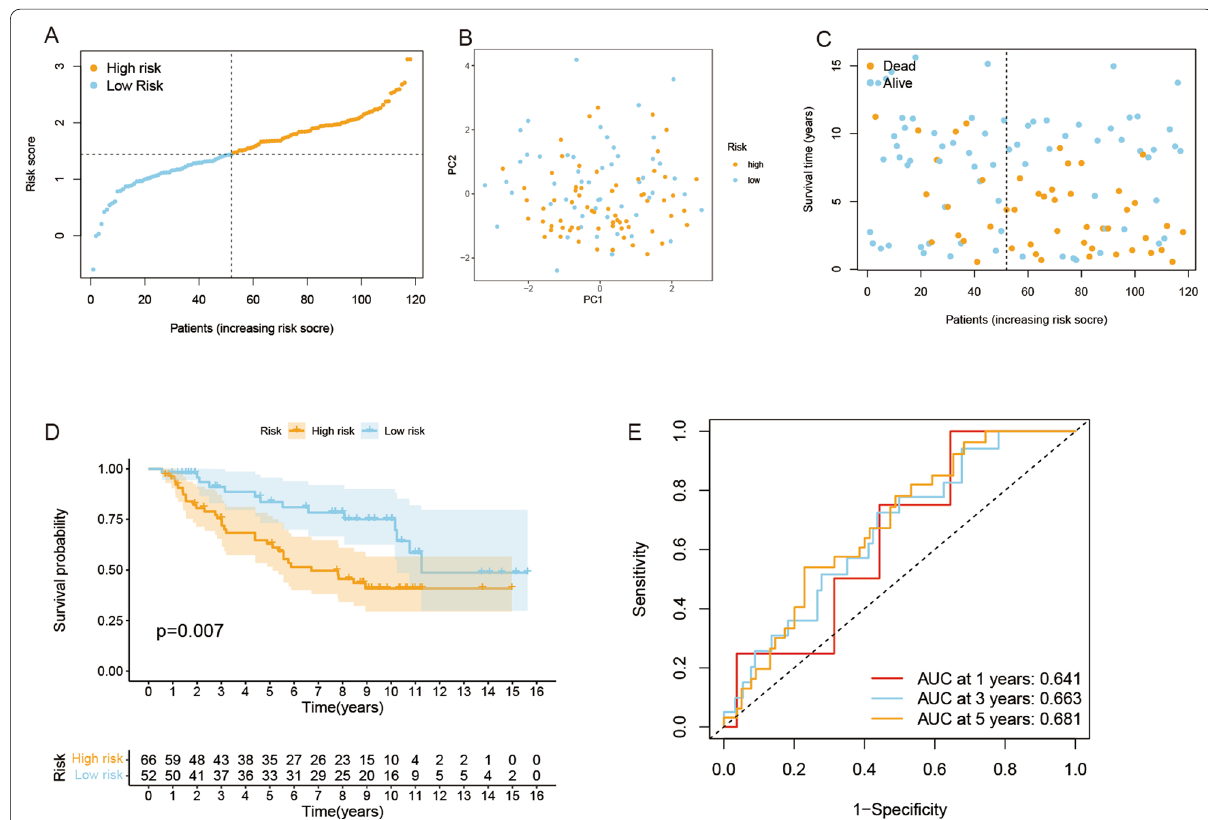
Fig. 4 Validation of the risk model in the GEO cohort. A Distribution of patients in the GEO cohort based on the median risk score in the TCGA cohort. B PCA plot for HCCs. C The survival status for each patient (low-risk population: on the left side of the dotted line; high-risk population: on the right side of the dotted line). D Kaplan–Meier curves for comparison of the OS between low- and high-risk groups. E Time-dependent ROC curves for